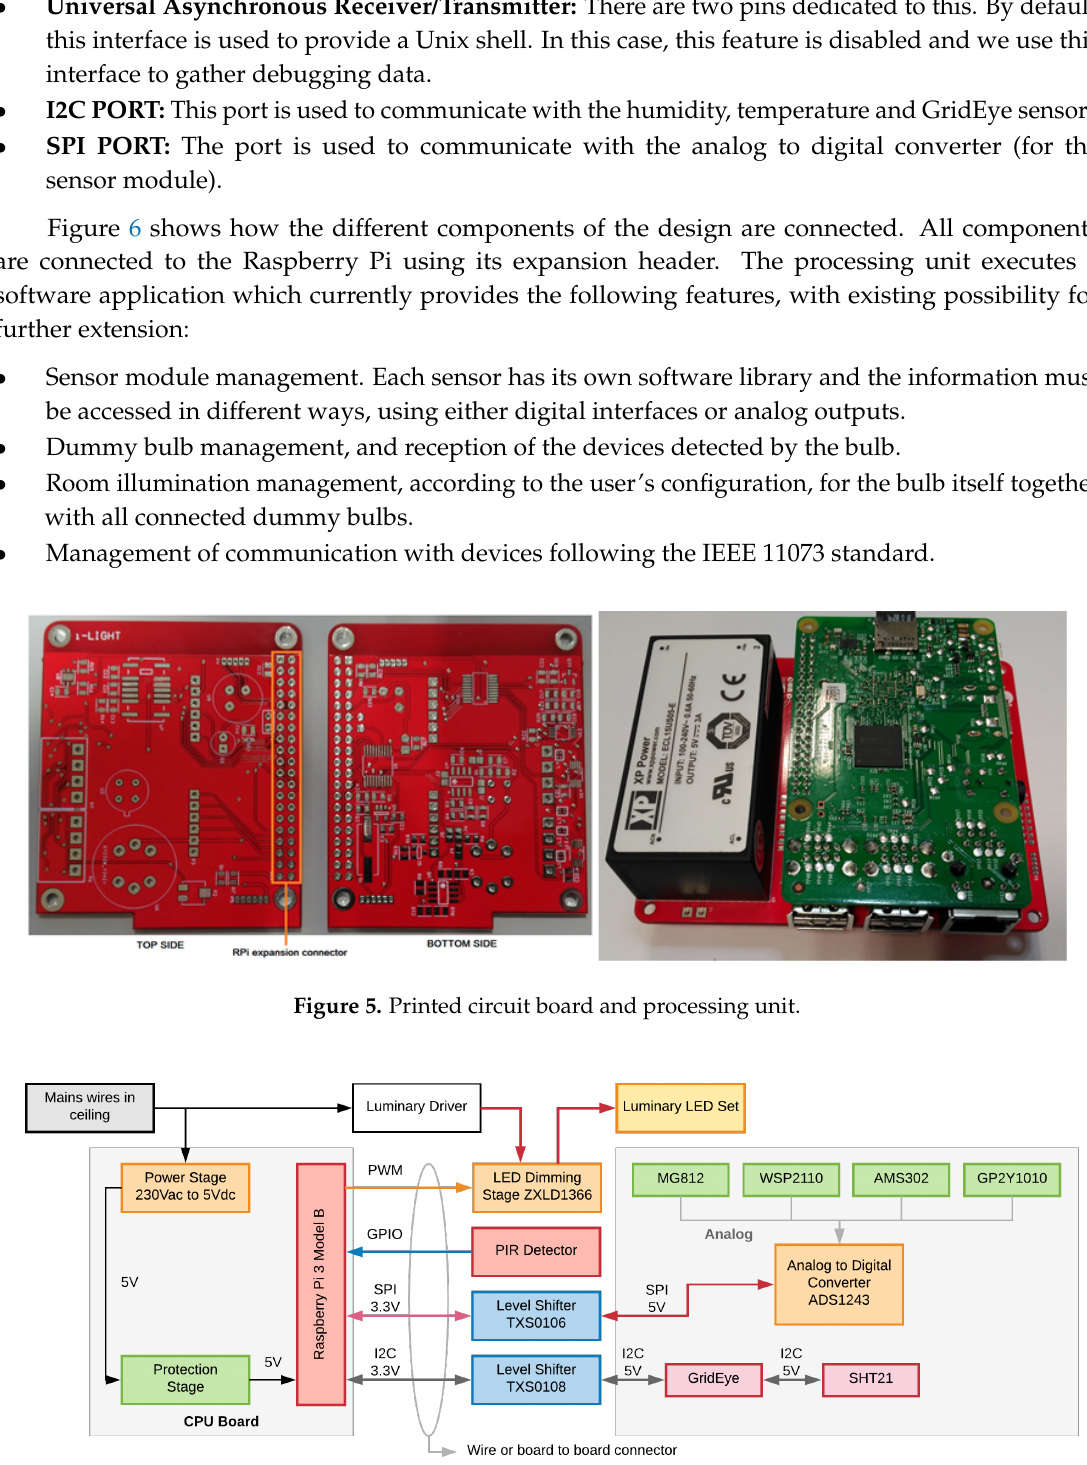
Figure 6. Connections between the different components of the